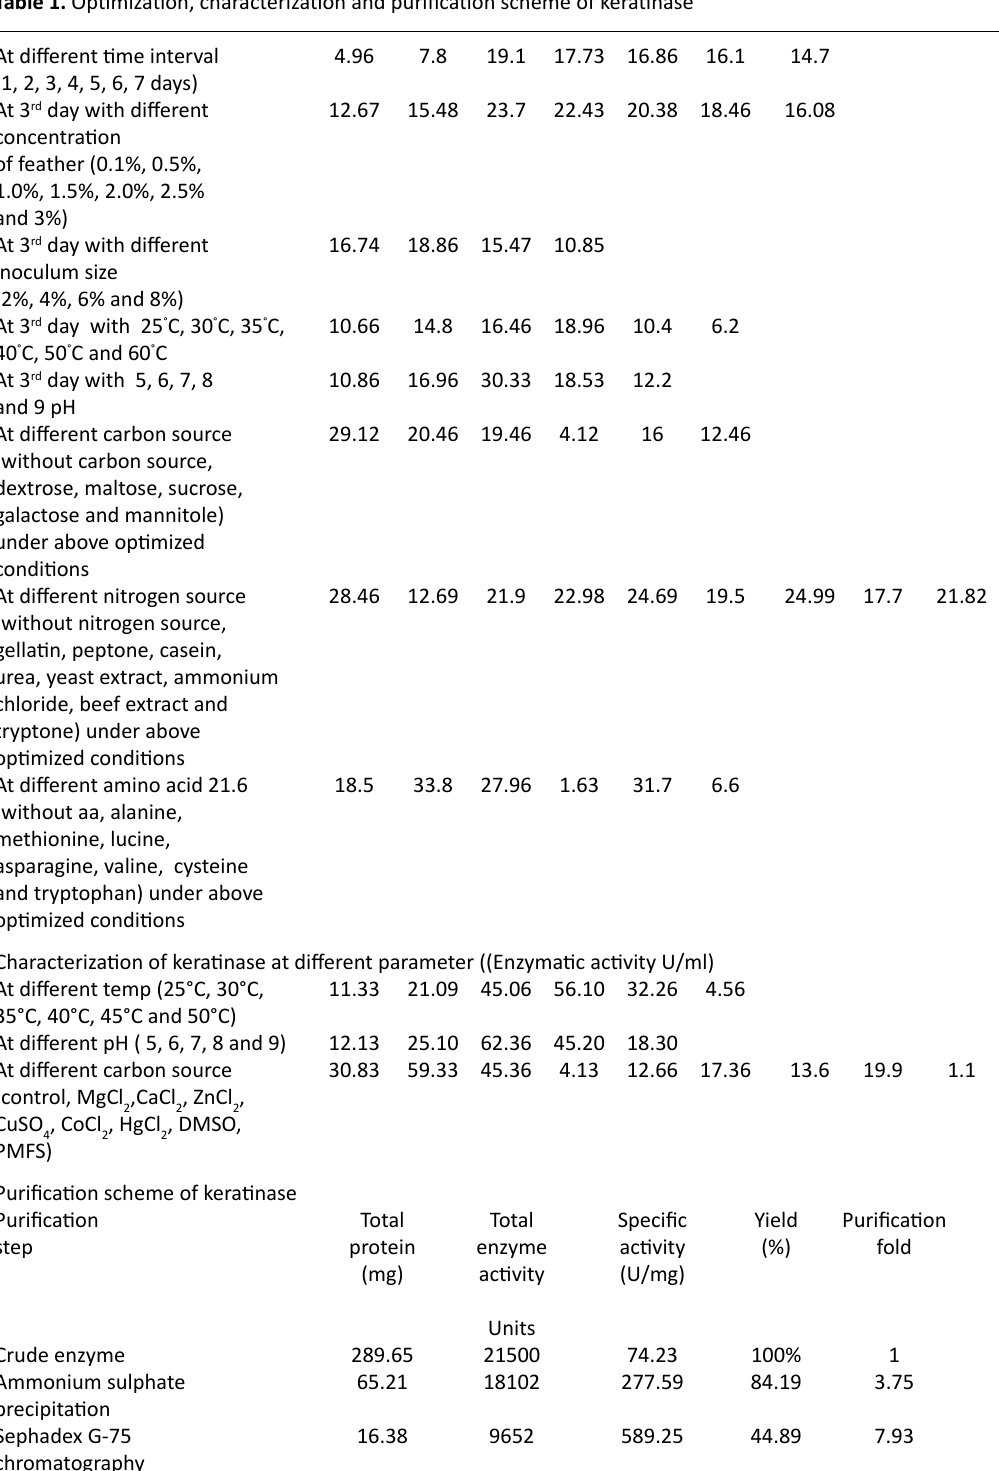
Table 1. Optimization, characterization and purification scheme of keratinase At different time